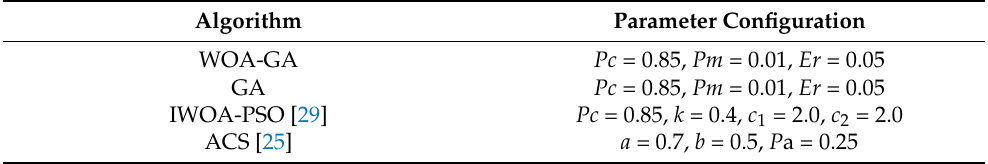
Table 3. Parameter configuration of each algorithm.